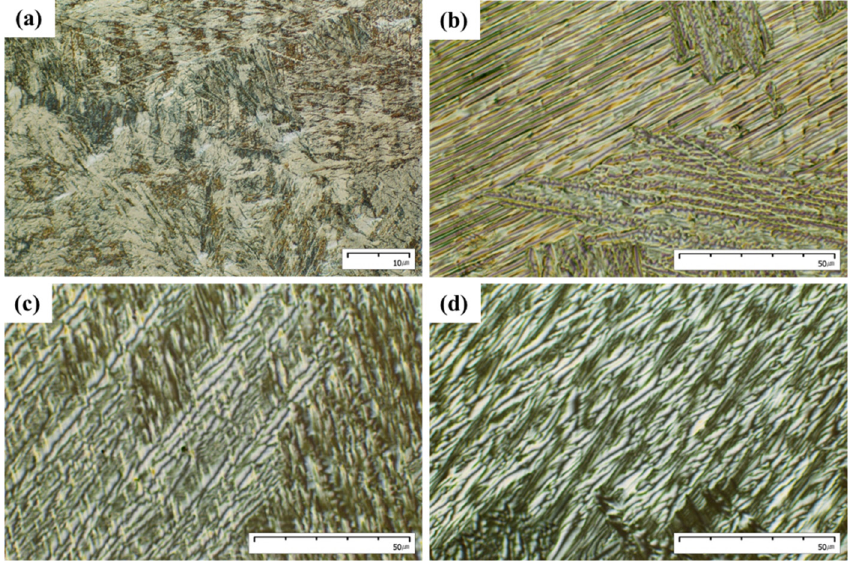
Figure 4. Optical micrographs of Ti- x In alloys: ( a ) Ti-5In, ( b ) Ti-10In, ( c ) Ti15In, and ( d ) Ti-20In.